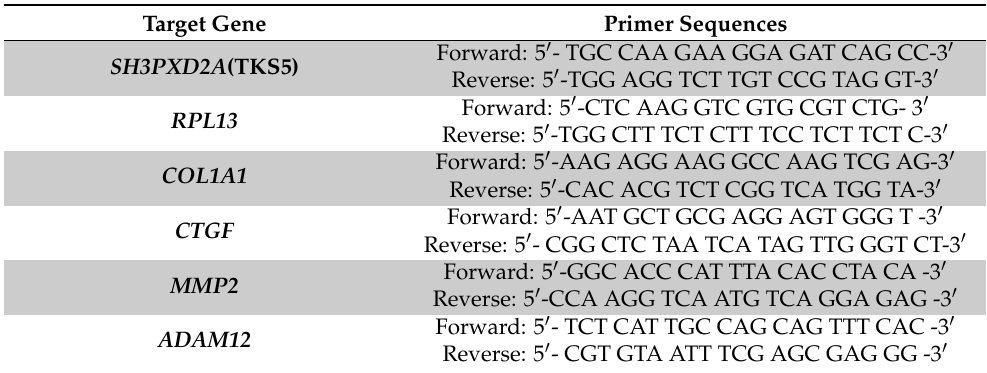
Table 2. Primer sequence used for